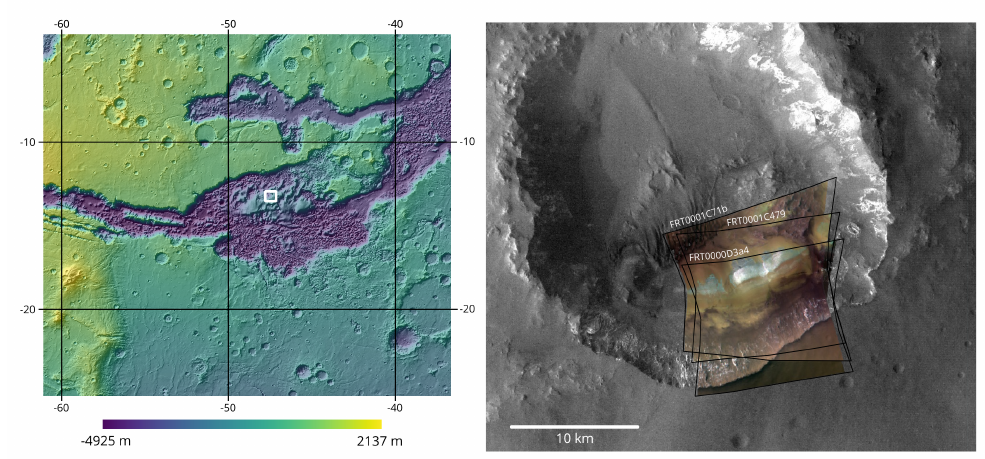
Figure 1. Location map of the used cubes in the present work. Left : color-coded MGS MOLA hillshade over Coprates Chasma and surrounding plateau; the white outline indicates the extent of the right panel (data). Right : location of the three overlapping CRISM observations used here; the background imagery consists of HRSC Level4 Nadir imagery, orbit